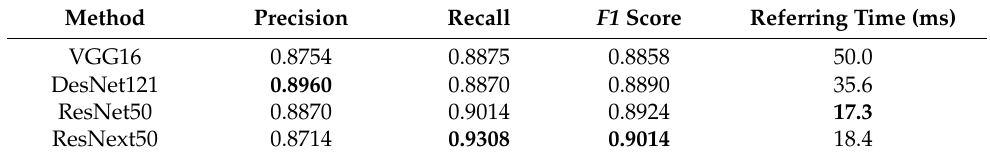
Table 4. Comparison of prediction performance with different models (bold means the best result).